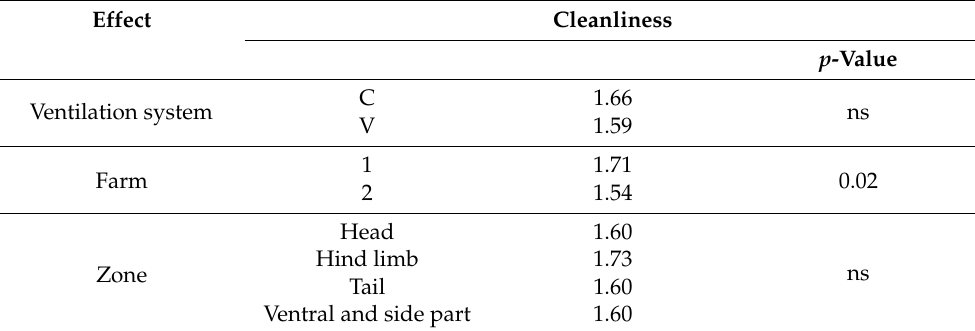
Table 3. Effect of ventilation system treatment, farm and body zone on cleanliness. Values ranged from 1 to 3 (1 = clean with a few small dirt spots at most; 2 = moderately dirty; 3 = mostly covered in